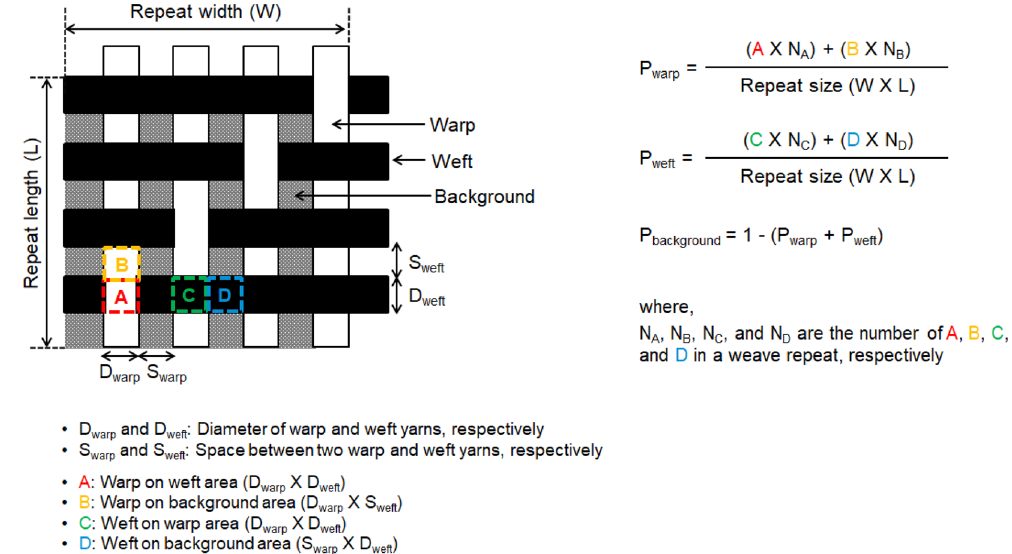
Figure 2. Principle of two-dimensional geometrical modeling of woven